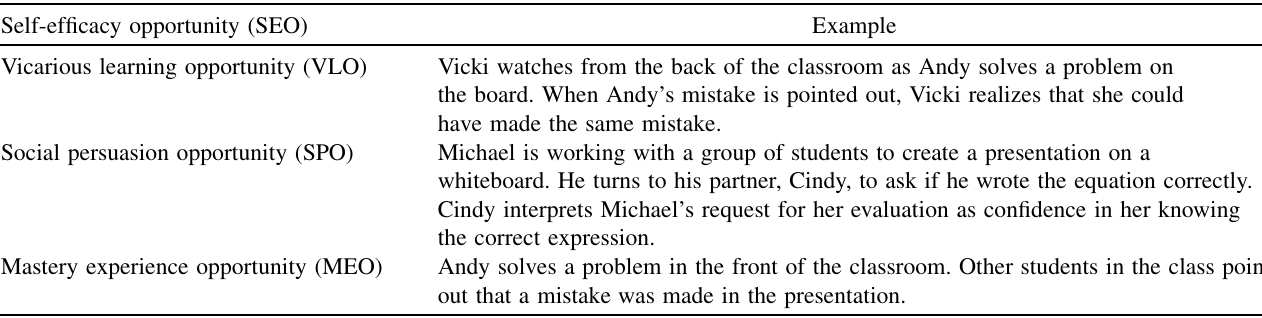
TABLE II. Touchstone examples of self-efficacy opportunities. Self-efficacy opportunity (SEO)